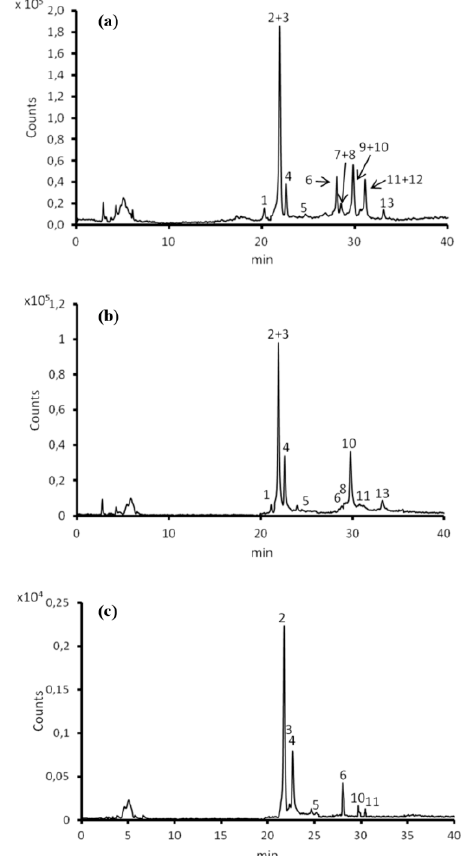
Figure 10. Representative High-Performance Liquid Chromatography–Electrospray Ionization- Quadrupole-Time-Of-Flight (HPLC/ESI/Q-TOF) trace of extracts: exocarp ( a ), endocarp ( b ) and mesocarp ( c ).